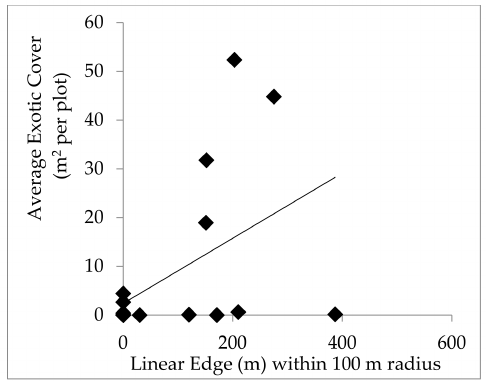
Figure A2. Linear regression of the average total exotic cover (%) prior to disturbance plotted against the amount of linear edge (m) within a 100 m radius of each disturbed plot. y = 0.07 x + 2.38, p -value = 0.042, R 2 = 0.22.